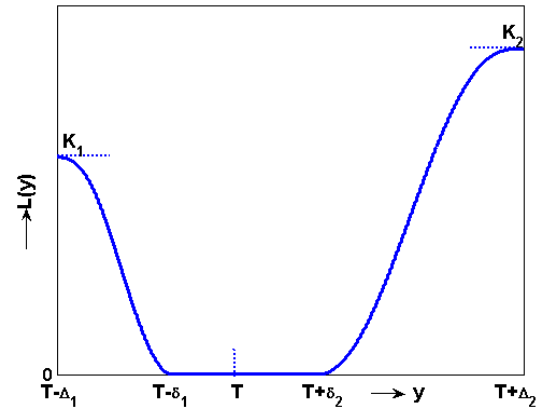
Figure 2. General form of the proposed polynomial loss function (PLF) The shape parameter β adjusts the penalty for de– partures of a quality characteristic from the desired target T .